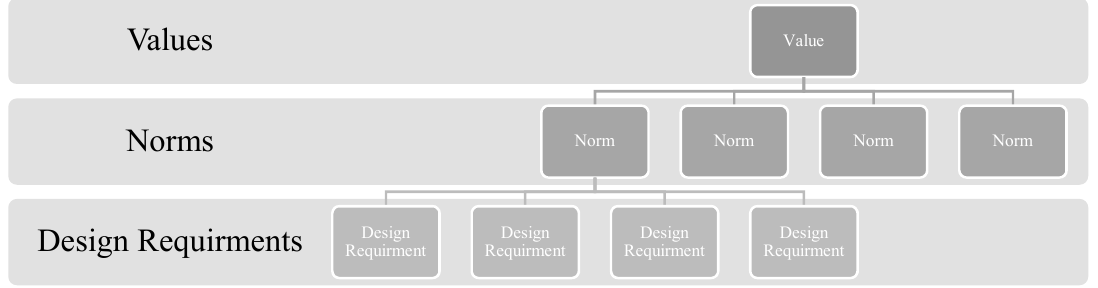
Figure 1. Top-Down Values hierarchy (Source: [48]).